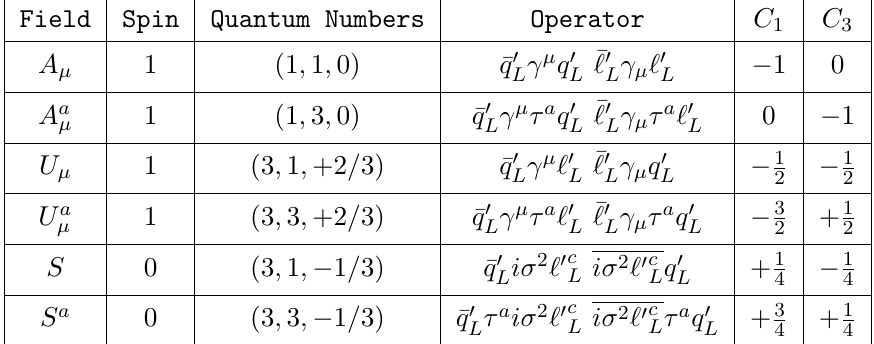
Table 11 . Spin zero and spin one mediators contributing, at tree-level, to the Lagrangian L 0 of eq. (2.3). Also shown are the operators they give rise to and the contribution to the coe(cid:14)cients C 1 and C 3 of the Lagrangian L 0 ((cid:3)), when a single fermion generation is involved. NP